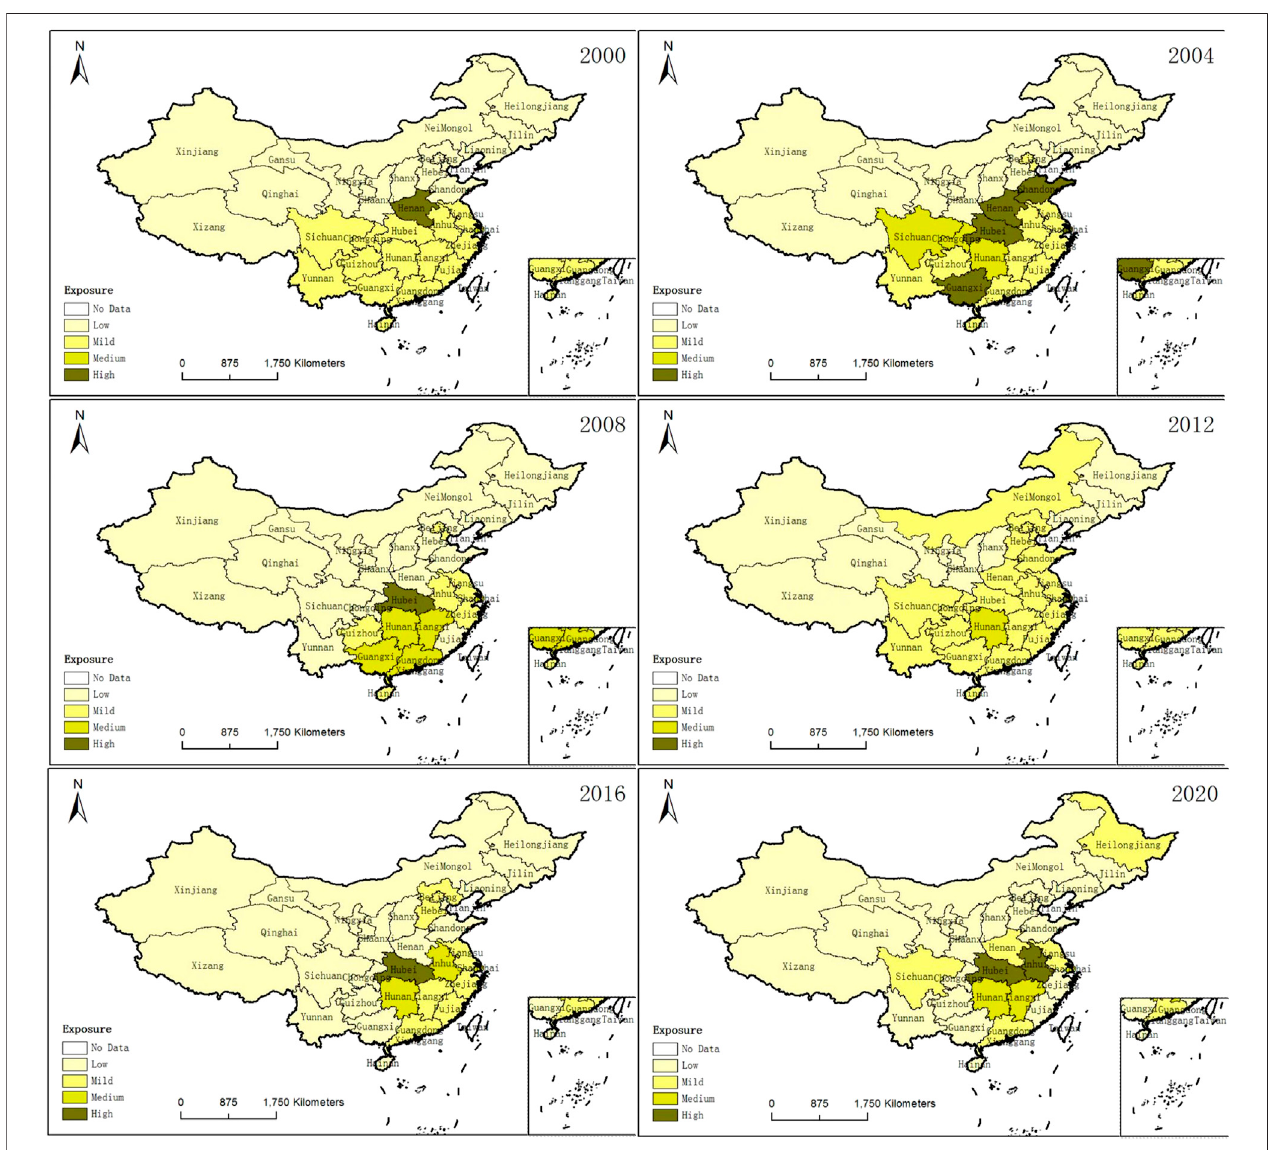
FIGURE 2 | Temporal and spatial variation of agricultural fl ood exposure in